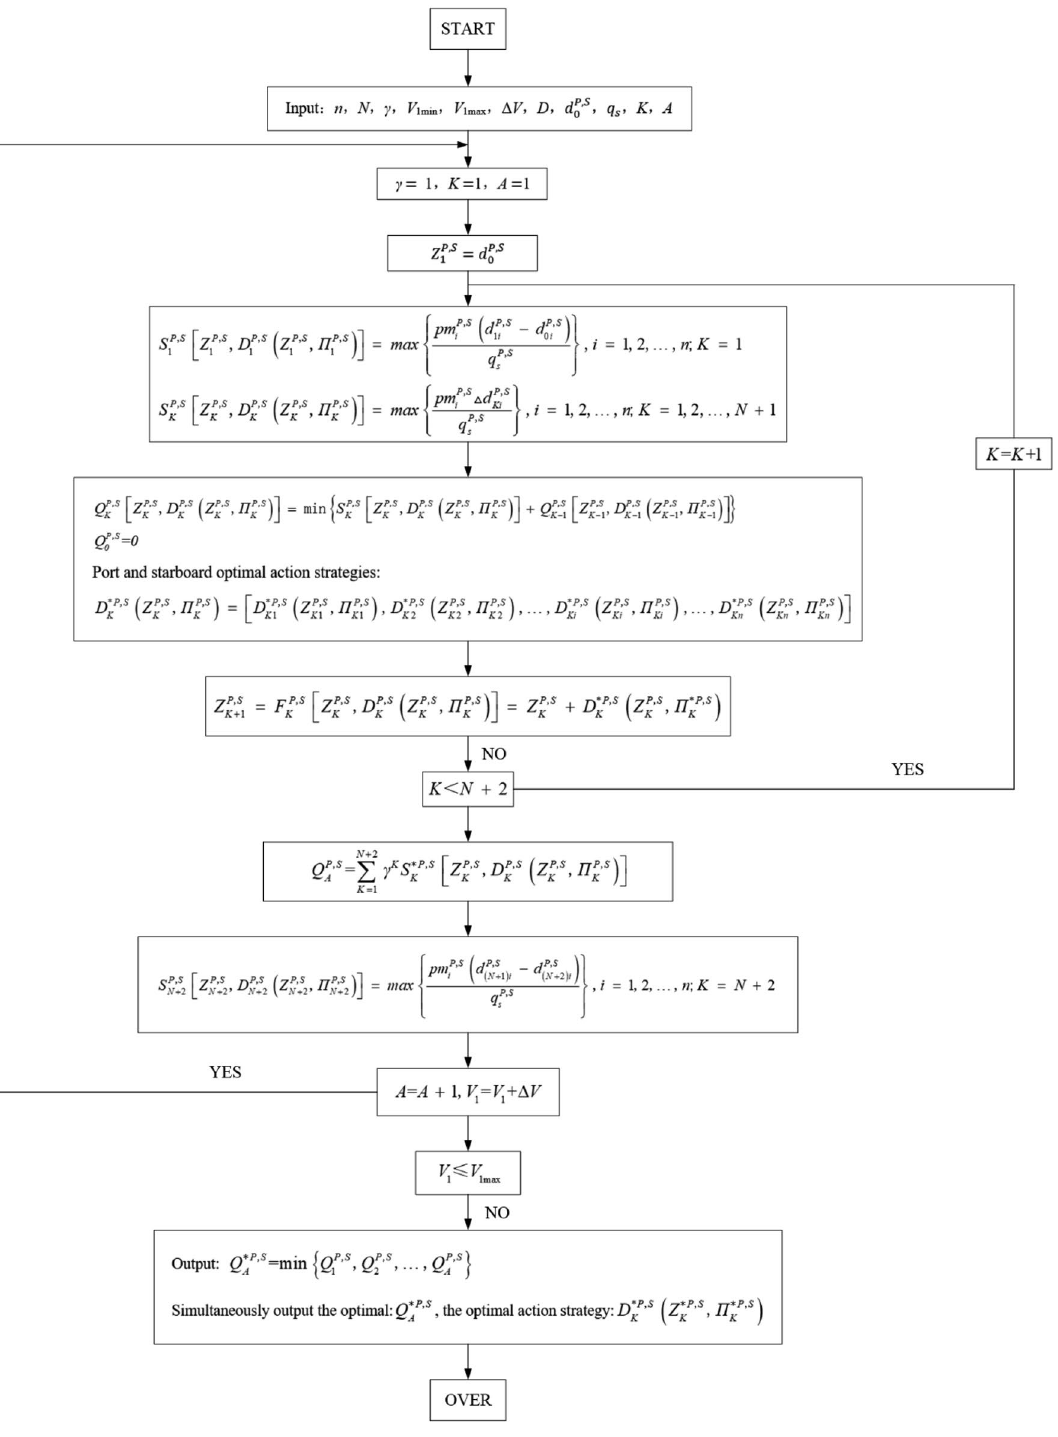
Figure 11. Calculation flow chart of the optimization